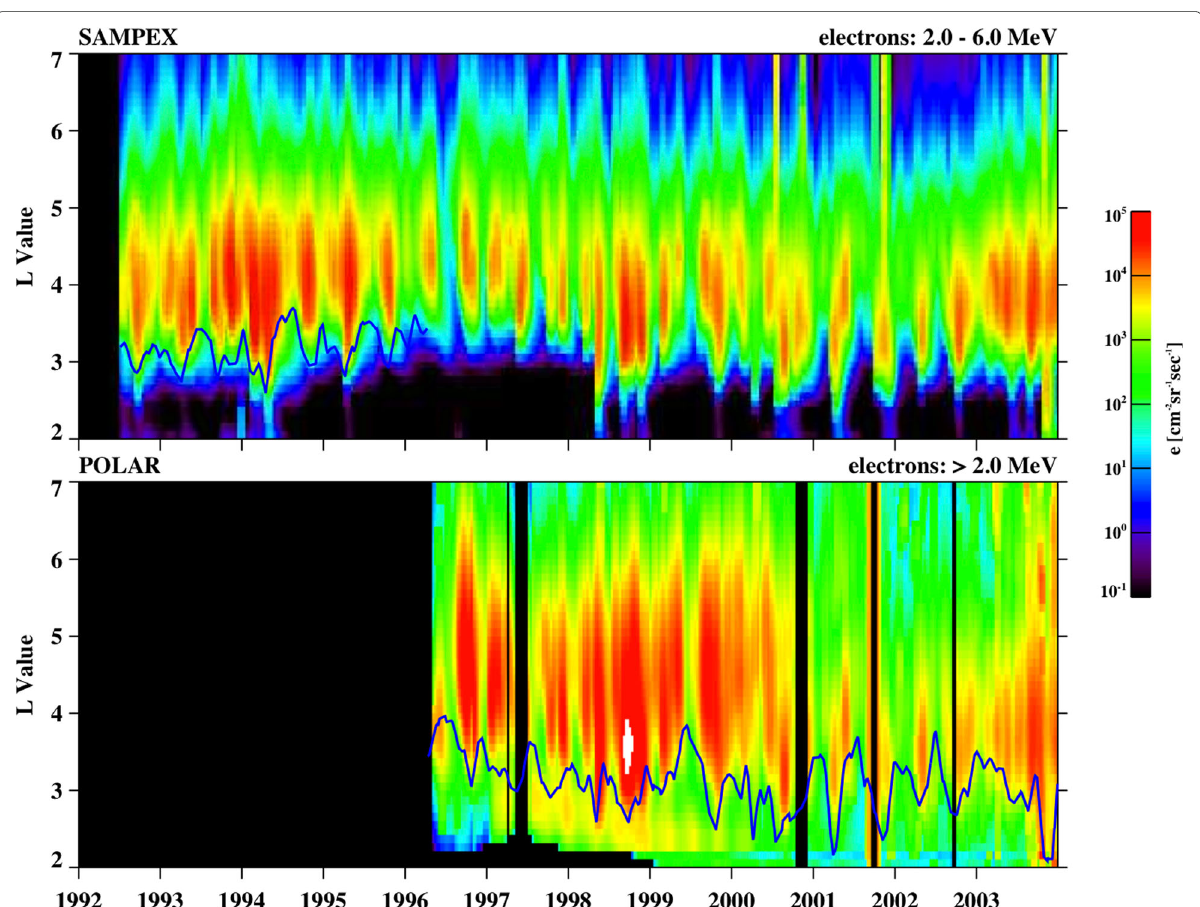
Fig. 8 Energetic electron intensities measured by instruments onboard SAMPEX (top) and Polar (bottom) satellites. Daily averaged fluxes spanning over a decade (1992 to 2003) are shown for 2.0 to 6.0 MeV and > 2.0 MeV electrons. The electron intensities are smoothed with a 30-day running box-car average. Also shown as a blue trace model calculated location of the plasmapause multiplied by a factor of 1.3. Figure is reproduced from Kanekal